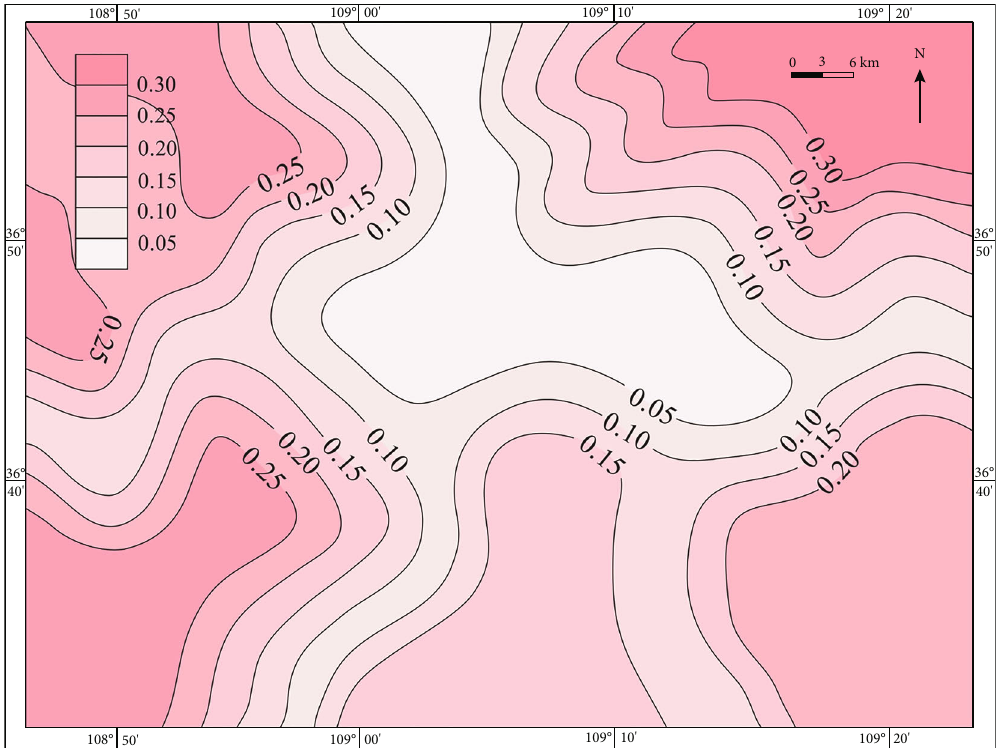
Figure 9: Distribution map of Mg 2+ /Ca 2+ ratios; the contour line represents speci fi c numerical values.